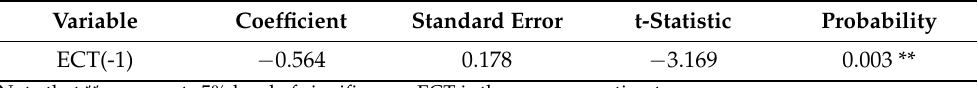
Table 7. P-ARDL error correction model result: INP, INF, EDU, PRO, DEP, INC. Variable Coefficient Standard Error t-Statistic Probability ECT(-1) − 0.564